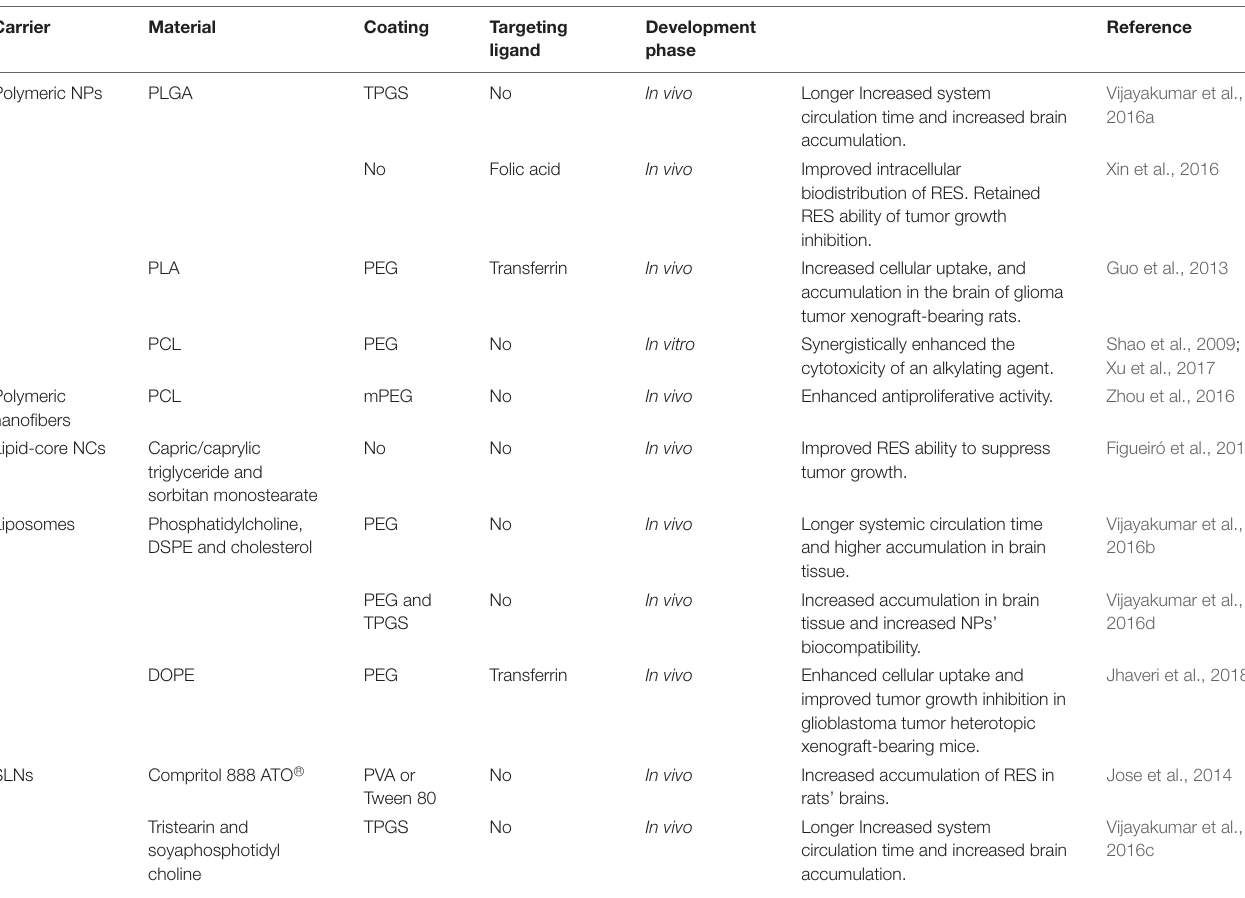
TABLE 3 | Currently developed DDS for RES delivery for glioma’s